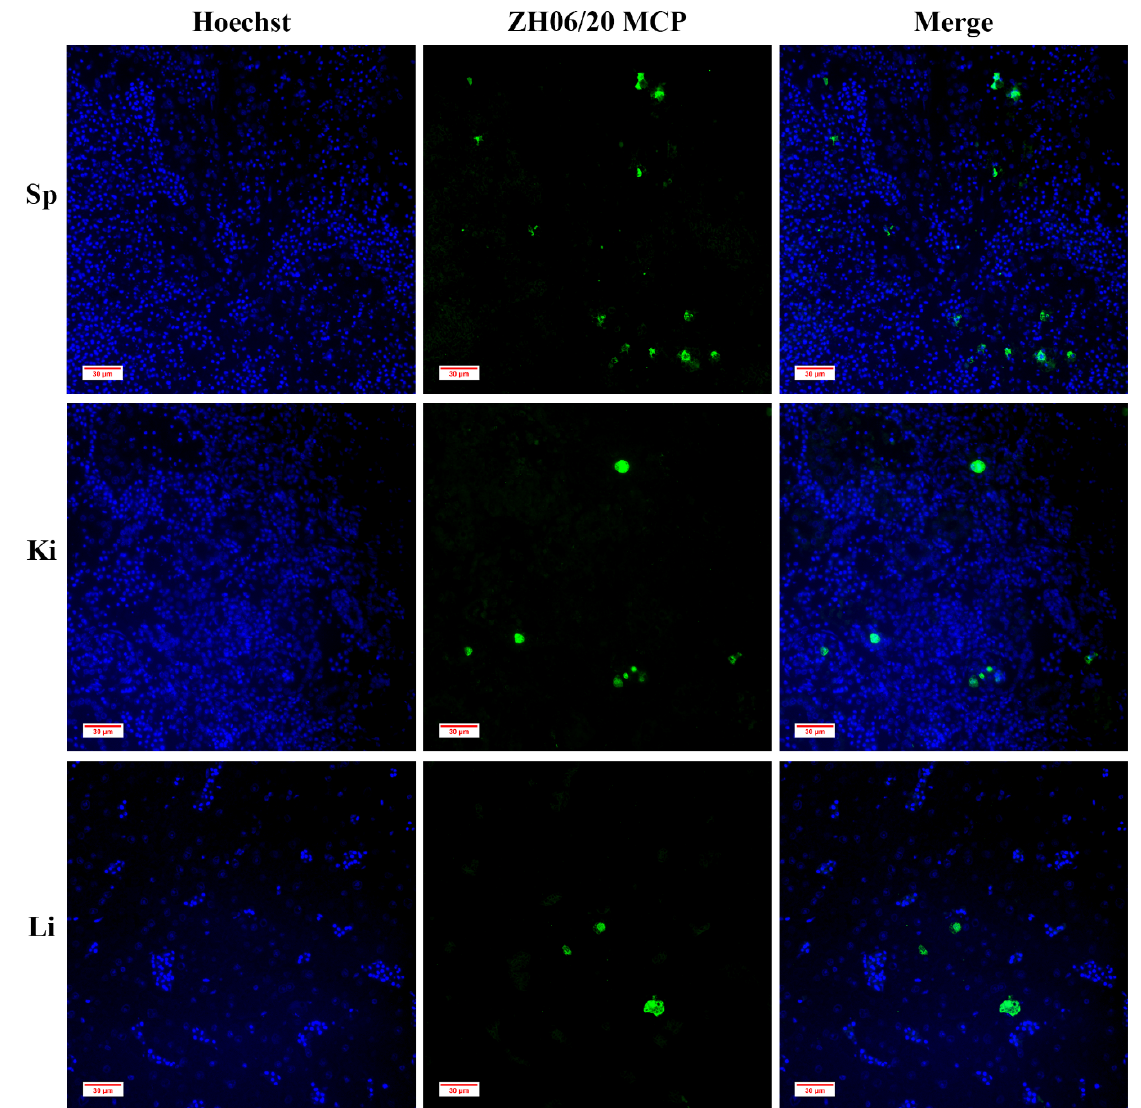
Figure 9. Immunofluorescence observation of infected tissues of spleen (Sp), kidney (Ki) and liver (Li). The infected cells are labeled by green fluorescence, which are associated with anti-ZH-06/20 MCP. Strongest fluorescence signals are observed in the spleen, then in the kidney and liver.